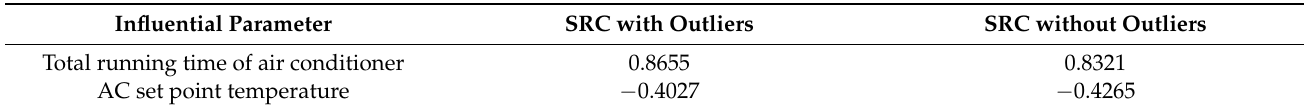
Table 6. SRC and p -values of linear relationship between AC energy consumption and total running time of the air conditioner and periodic average of AC set point temperature.